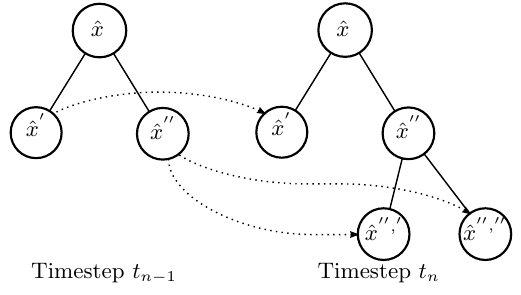
Figure 10: Solution tree for two time steps of a transient simulation, the dotted arrows show the source node for the backward Euler